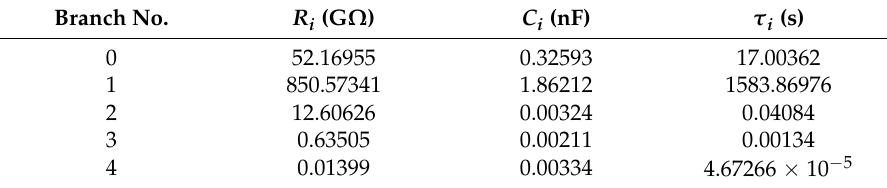
Table 2. The identified resistance and capacitance in extended Debye model (EDM) at 30 ◦ C. Branch No.